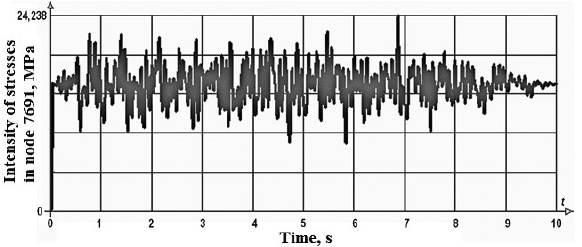
Figure 5. Time variation of calculated stresses in the critical